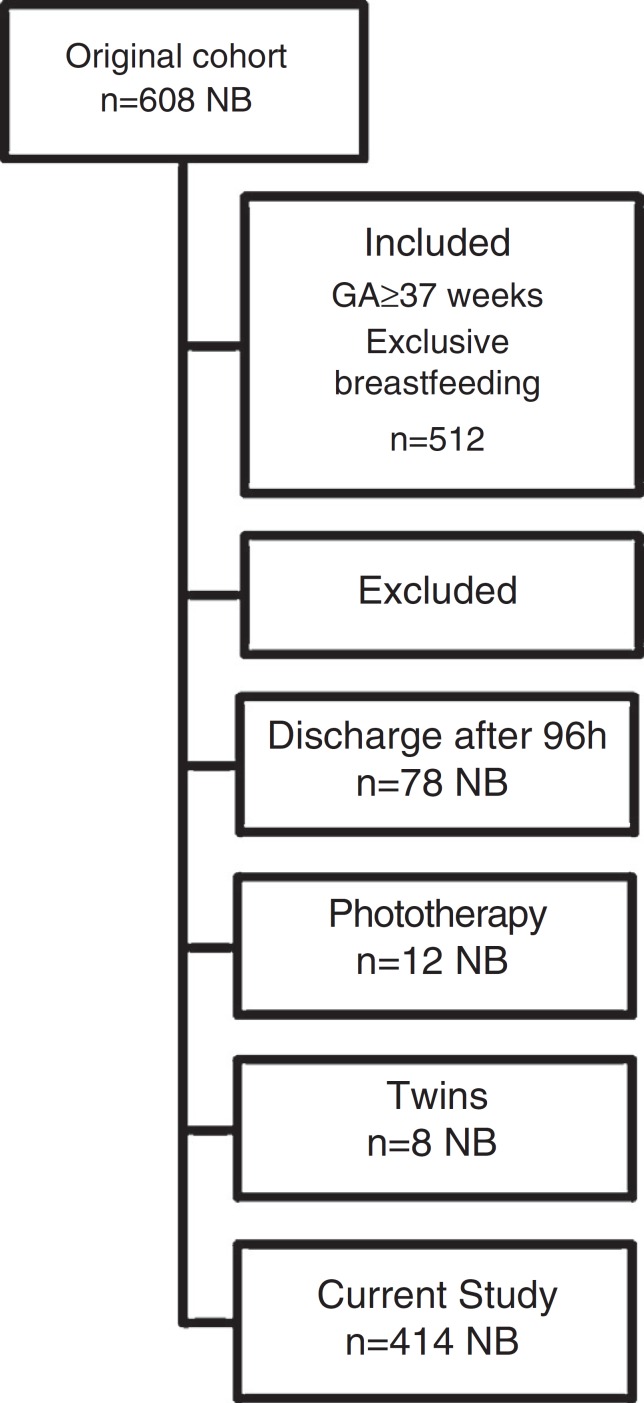
Cohort composition based on the original study.